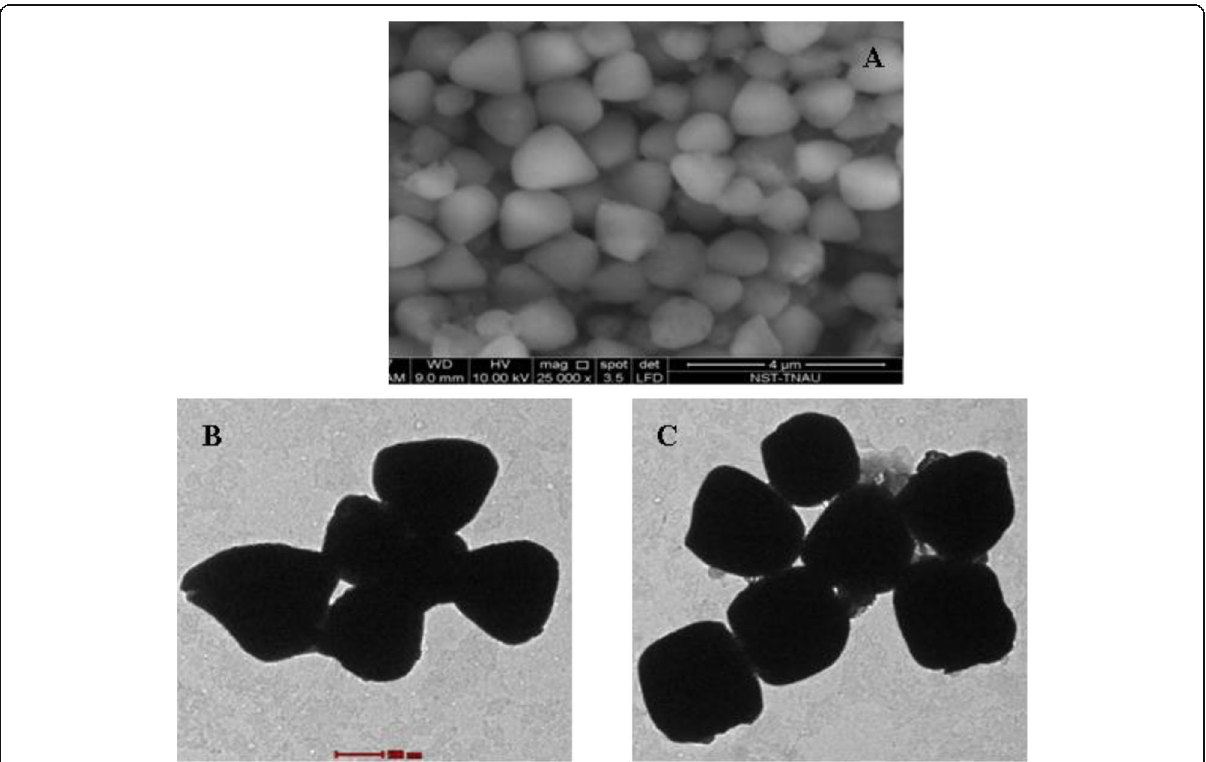
Fig. 2 Occlusion bodies (OBs) of SpobNPV. a Scanning electron micrograph of tetrahedral and triangular polyhedral OBs. b Transmission electron micrograph of triangular OBs. c Transmission electron micrograph of tetrahedral